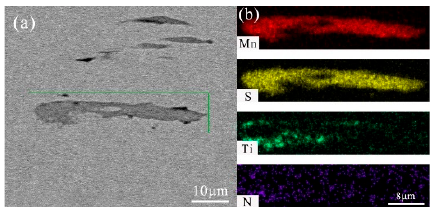
Figure 14. Typical MnS patterns pinned by TiN ( a ) SEM morphology of inclusions; ( b ) composition distribution of inclusions.